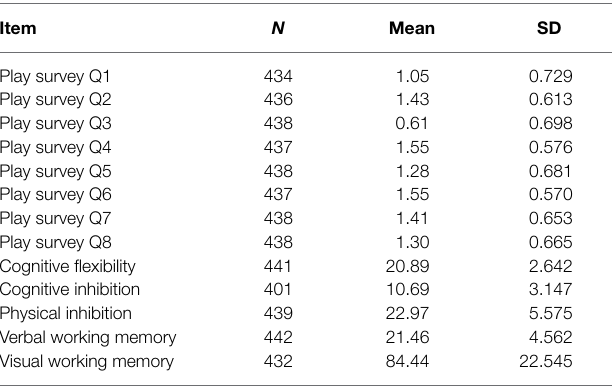
TABLE 1 | Descriptive statistics of Play Observed Behaviors Scale (POBS) items and EF measures.